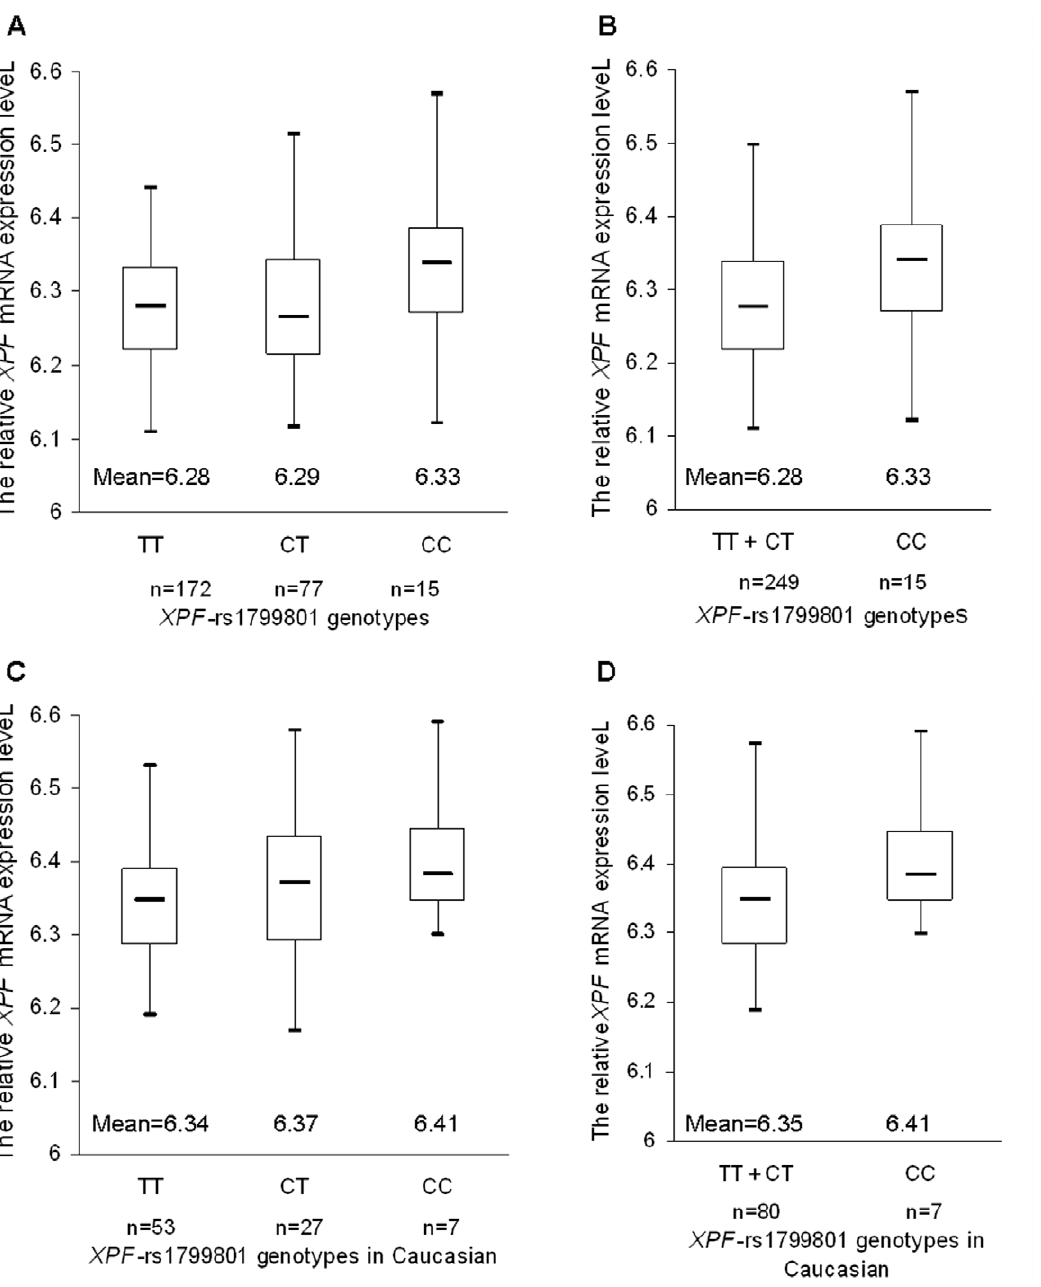
Figure 5. The relative expression levels of XPF transcripts by the known XPF -rs1799801 genotypes in 270 HapMap subjects. Homozygous variant CC genotype carriers showed a significant increased trend of XPF mRNA expression levels in overall populations, compare to (A) wild-type TT genotype ones, and (B) recessive reference TT + CT genotype ones (Student’s t test, P =0.032 and 0.046, respectively); but the difference in XPF transcript expression levels between the variant CC genotype and (C) wild-type TT genotype, and (D) TT + CT genotypes did not reach statistical significance (Student’s t test, P =0.063 and 0.127, respectively).